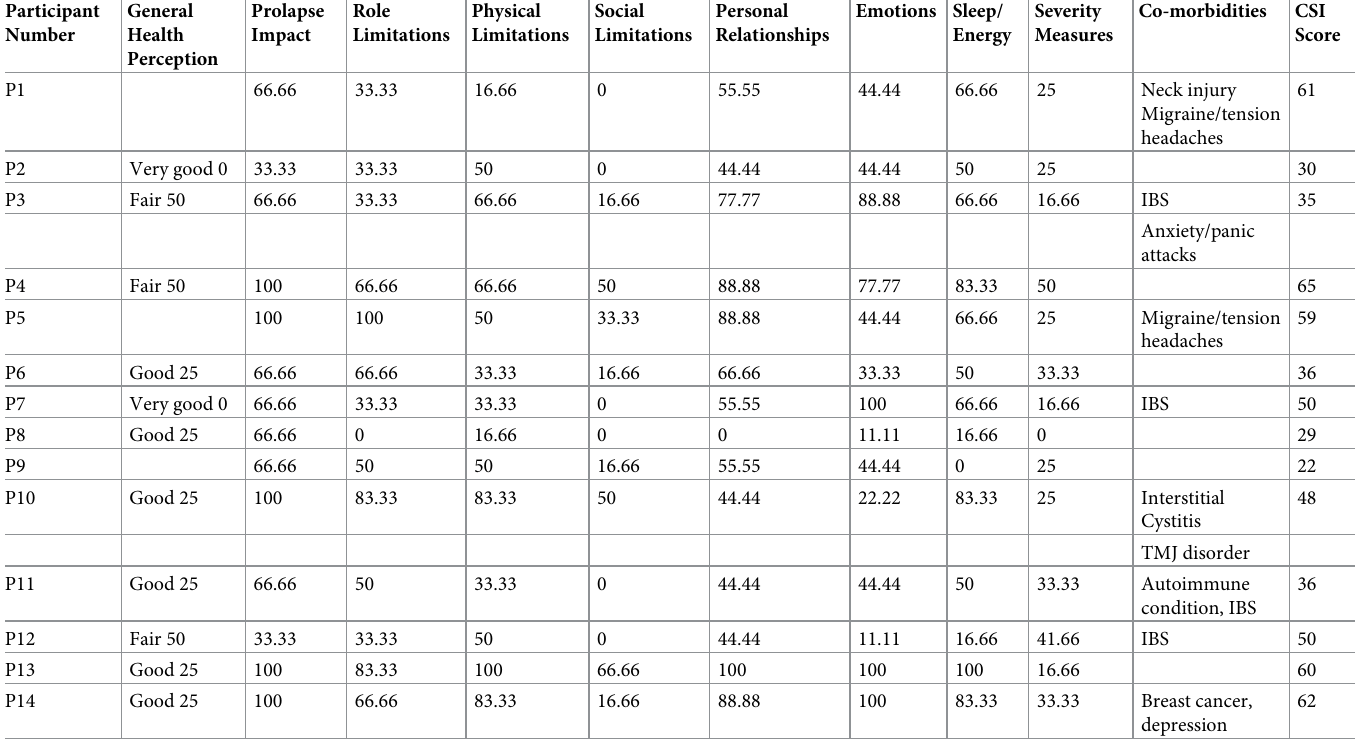
Table 3. Participant P-QOL & CSI